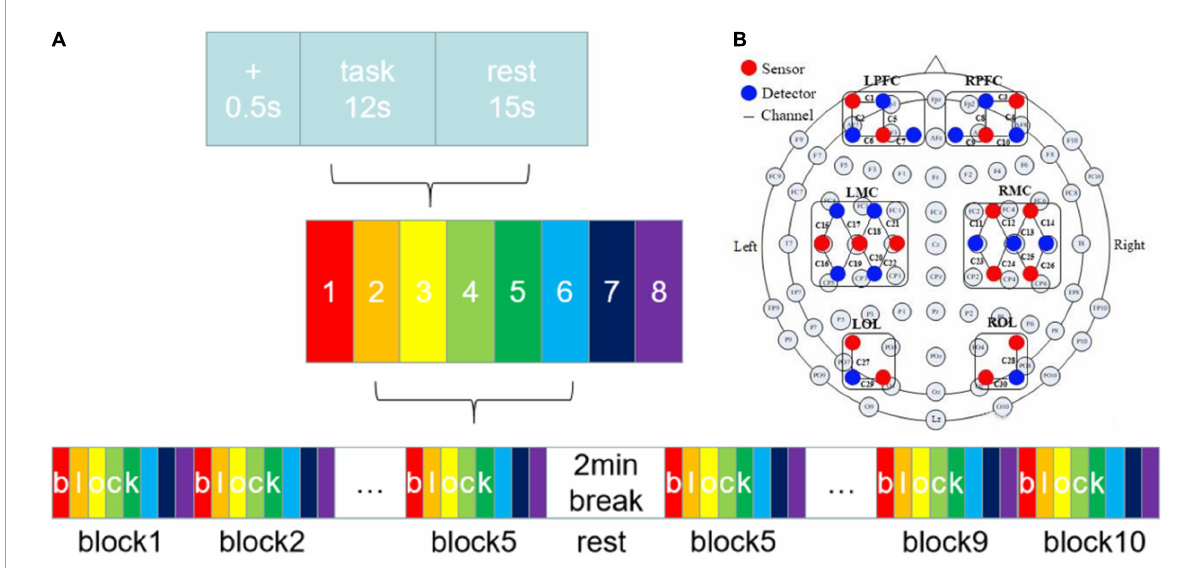
FIGURE1 (A) Experiment procedure. There were eight tasks in this study. (B) The layout of fNIRS channels. The red dots represented sources and the blue dots represented detectors. The 15 sources and 15 detectors constitute 30 channels, overlaying six brain regions: LPFC, RPFC, LMC, RMC, LOL, and ROL.